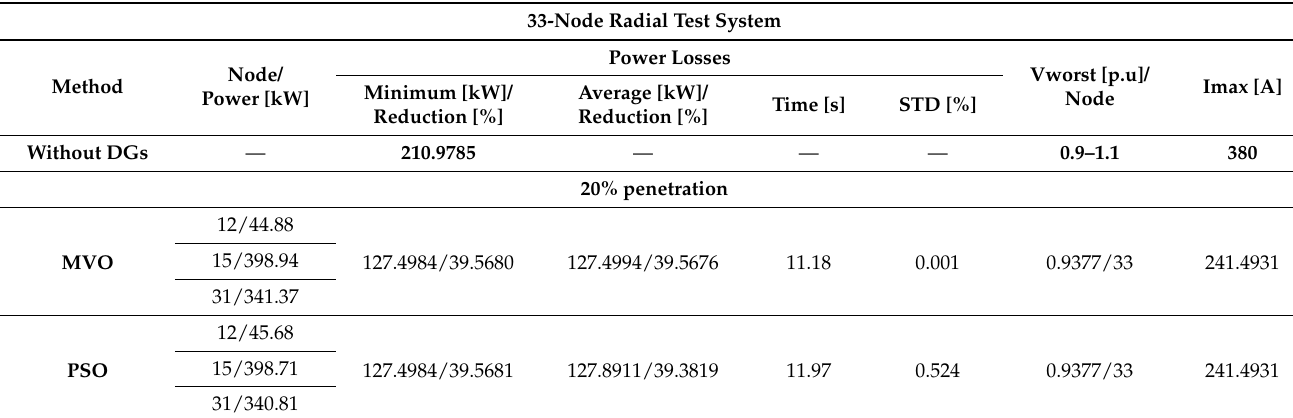
Table 8. Simulation results in the 33-node radial test